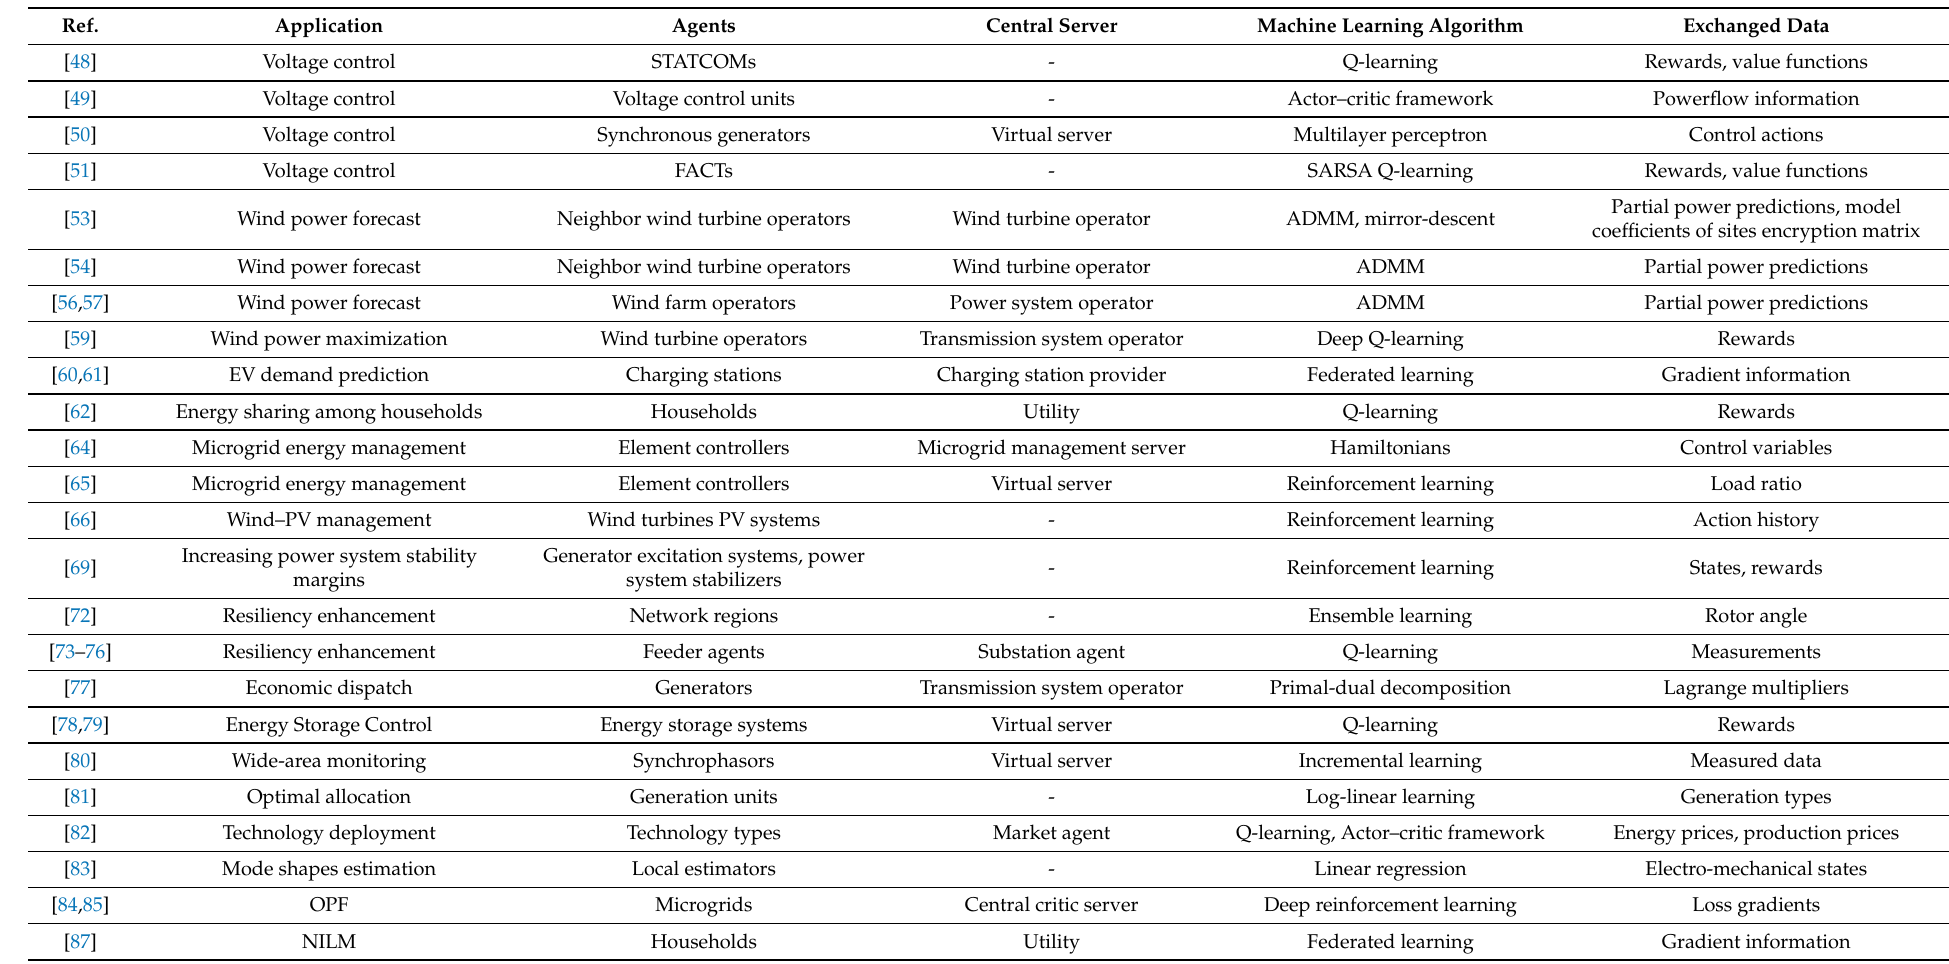
Table 2. Distributed learning applications